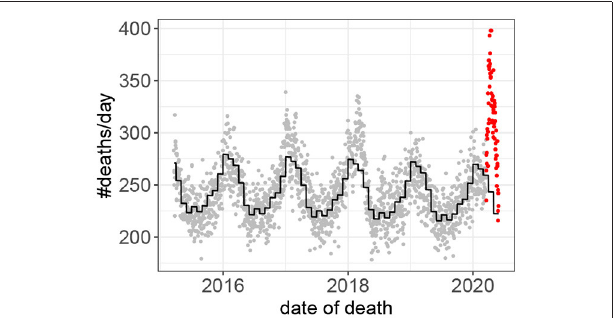
TABLE 1 | Outbreaks detected in the data. Onset Offset Duration (days) Mortality (per 10 5